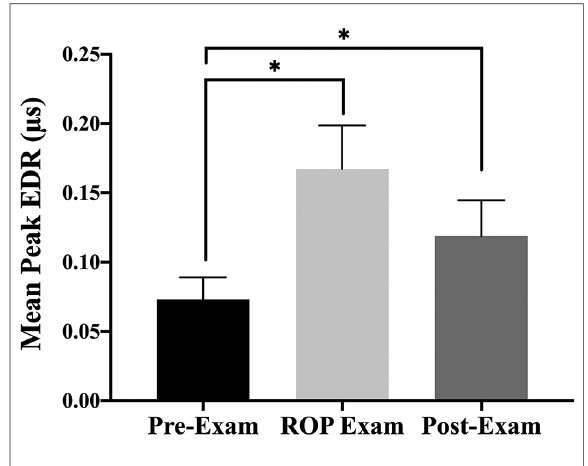
FIGURE 2 The bar graphs (SEM) illustrate mean of peaks (MPs) of skin conductance responses before the ROP examination, during the ROP examination, and after the ROP examination; *signi fi cant difference p <0.0017 by Wilcoxon signed rank tests with Bonferroni correction